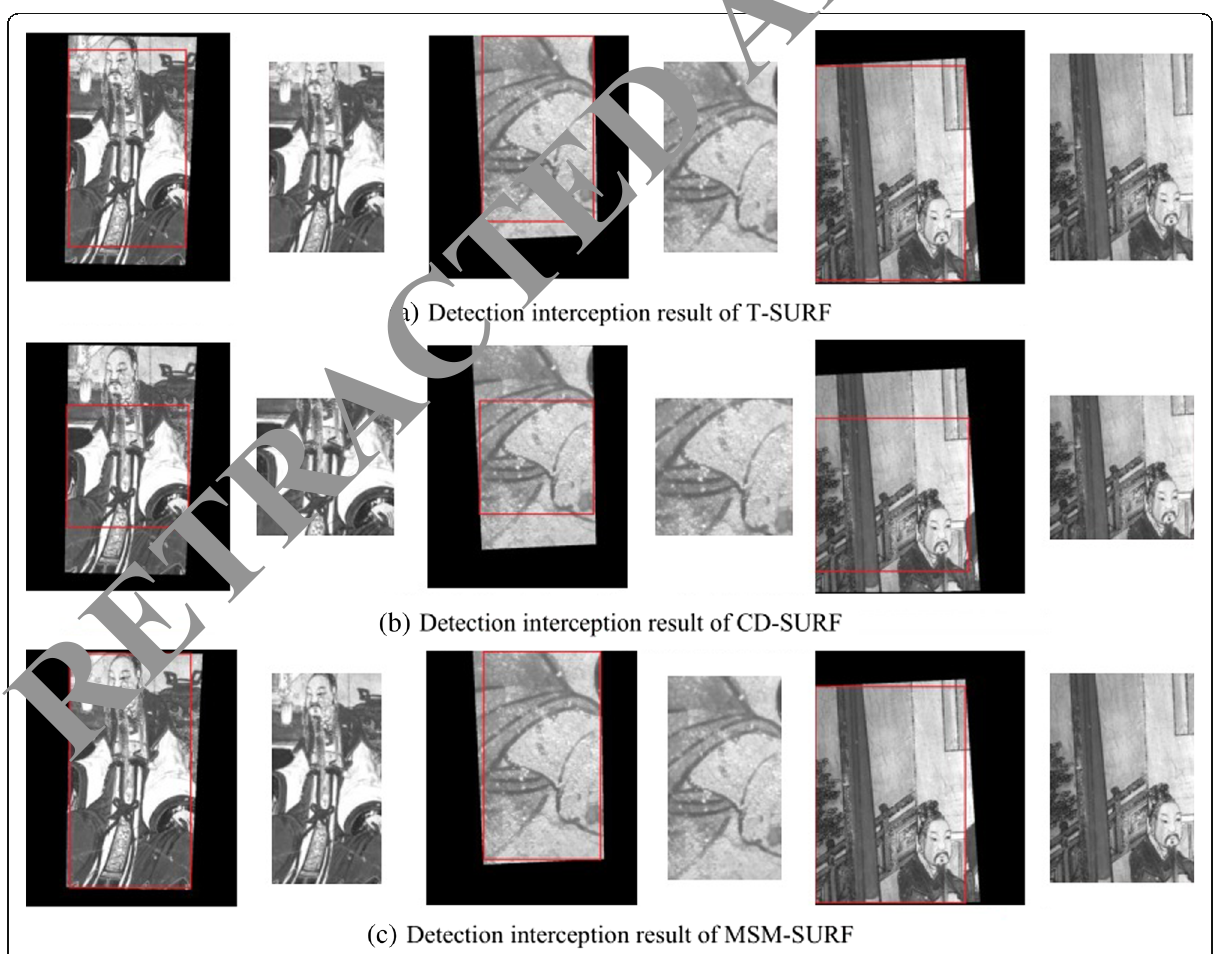
Fig. 8 Detection interception result of T-SURF, CD-SURF, and